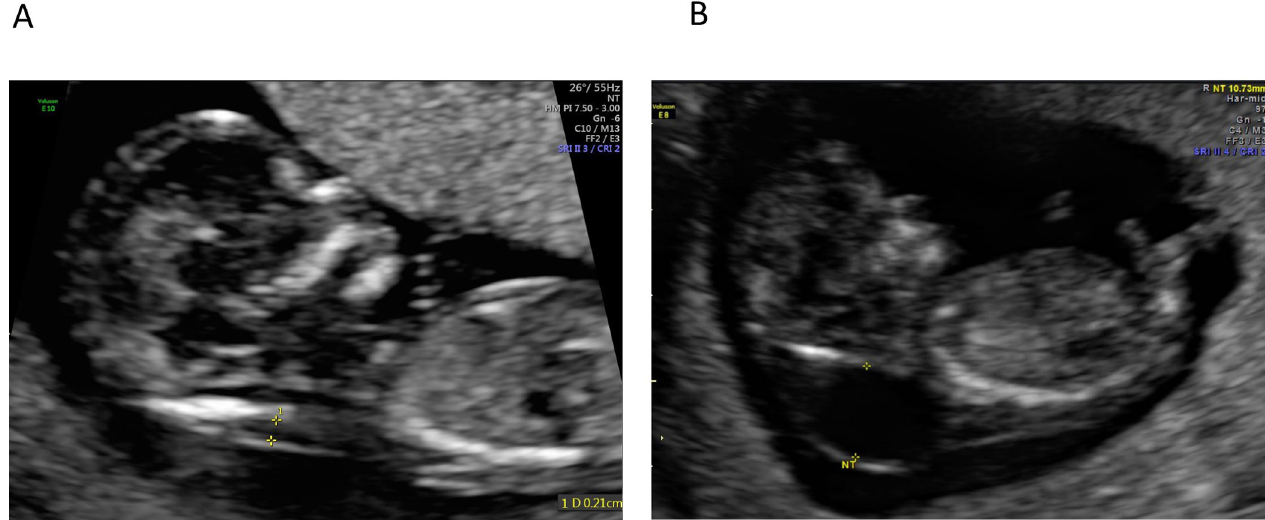
Fig 1. Fetal ultrasound images of normal (A) and cystic hygroma (B)